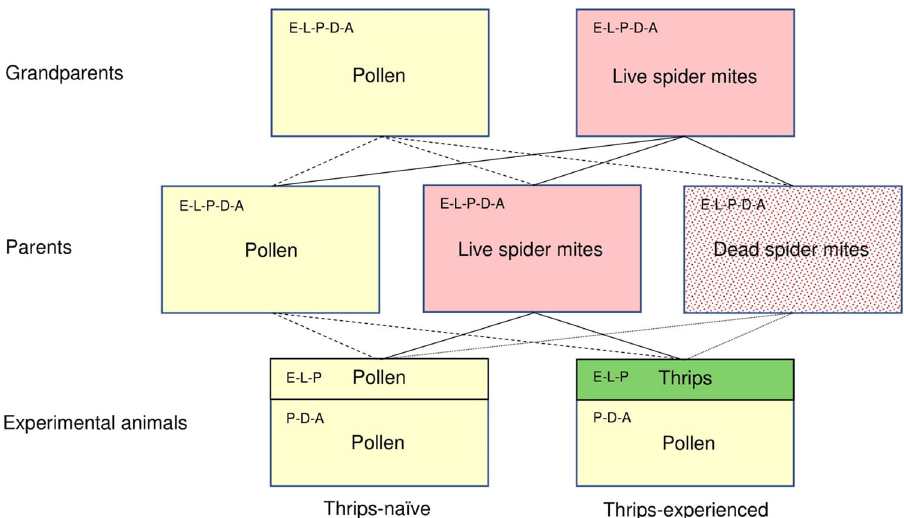
Fig. 1 Experimental design. Pre-experimental sequence of grandparental (F0), parental (F1), and personal (F2) diet experiences, representing a full 2 × 3 × 2 factorial design, resulting in 12 treatments of experimental animals (6 thrips-naïve and 6 thrips-experienced). Acronyms inside boxes are the life stages of the predators experiencing the diet indicated by the boxes; E for egg, L for larva, P for protonymph, D for deutonymph, and A for adult female. Mated experimental females that had experienced thrips early in life or not were then subjected to the behavioral